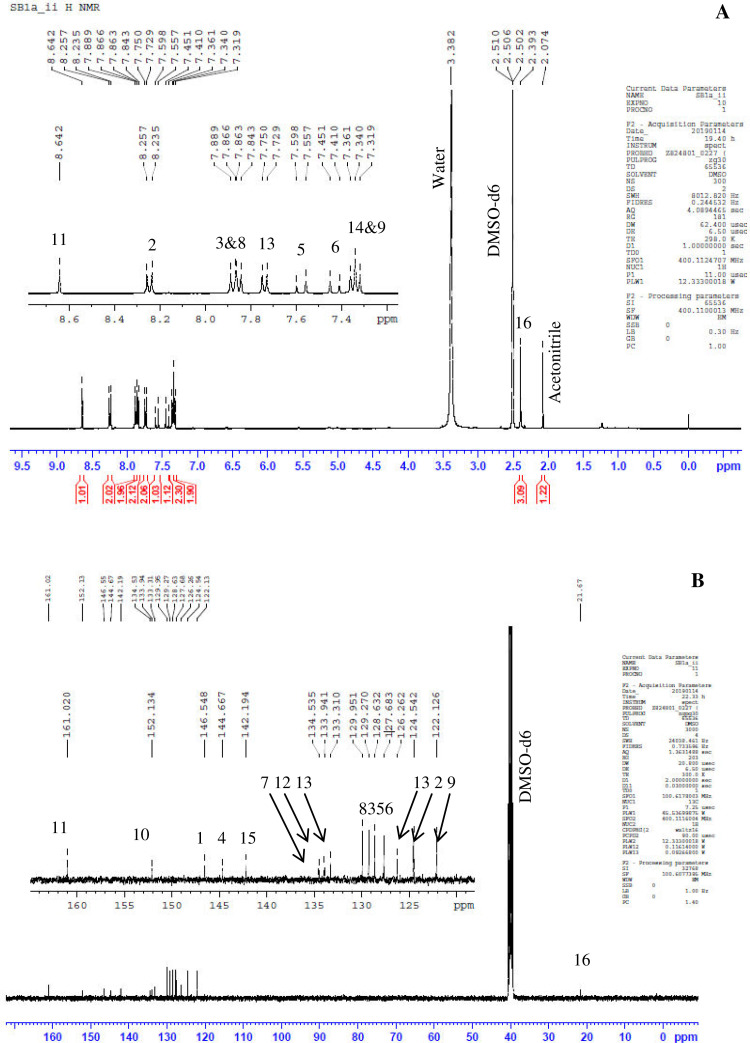
(A) 1H and (B) 13C NMR of NO2Me.